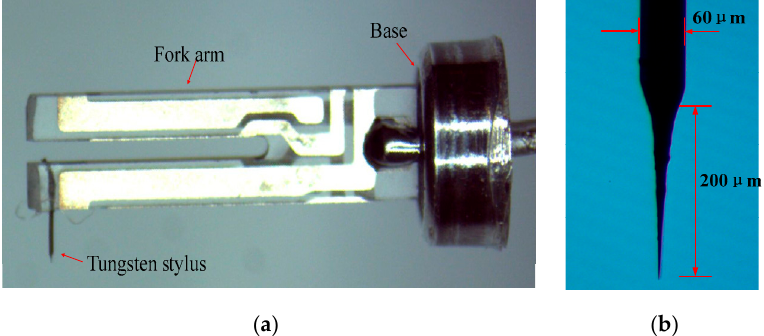
Figure 4. Photography of a scanning probe and tungsten stylus. ( a ) Photography of a scanning probe; ( b ) Photography of a tungsten stylus.